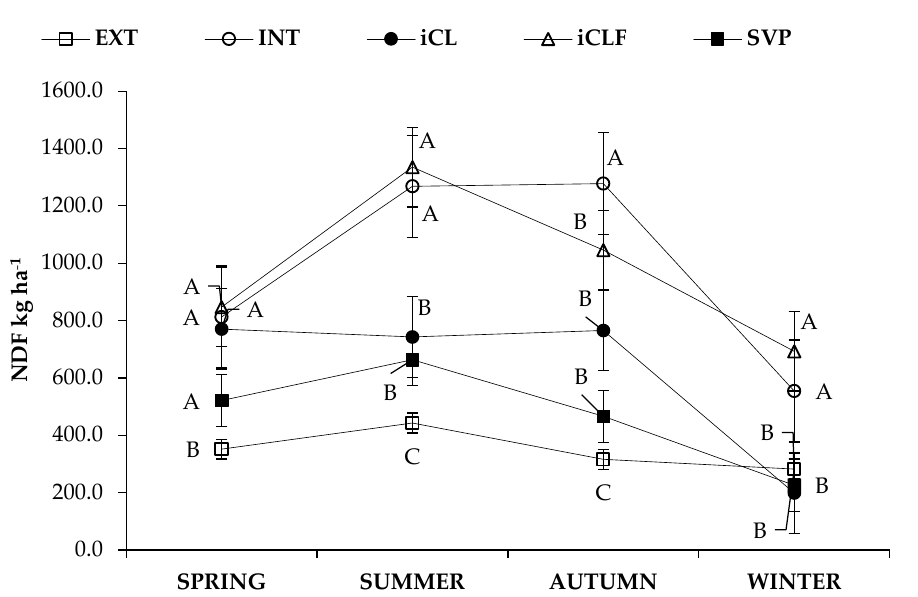
Figure A3. Crude protein (kg ha − 1 ) during seasons from different livestock production systems (means of two years). Different letters in the same season differ from each other ( p < 0.05) according to the Tukey test. EXT: extensive; INT: intensive; iCL: integrated crop–livestock; iCLF: integrated crop–livestock–forest; iLF: integrated livestock–forest.